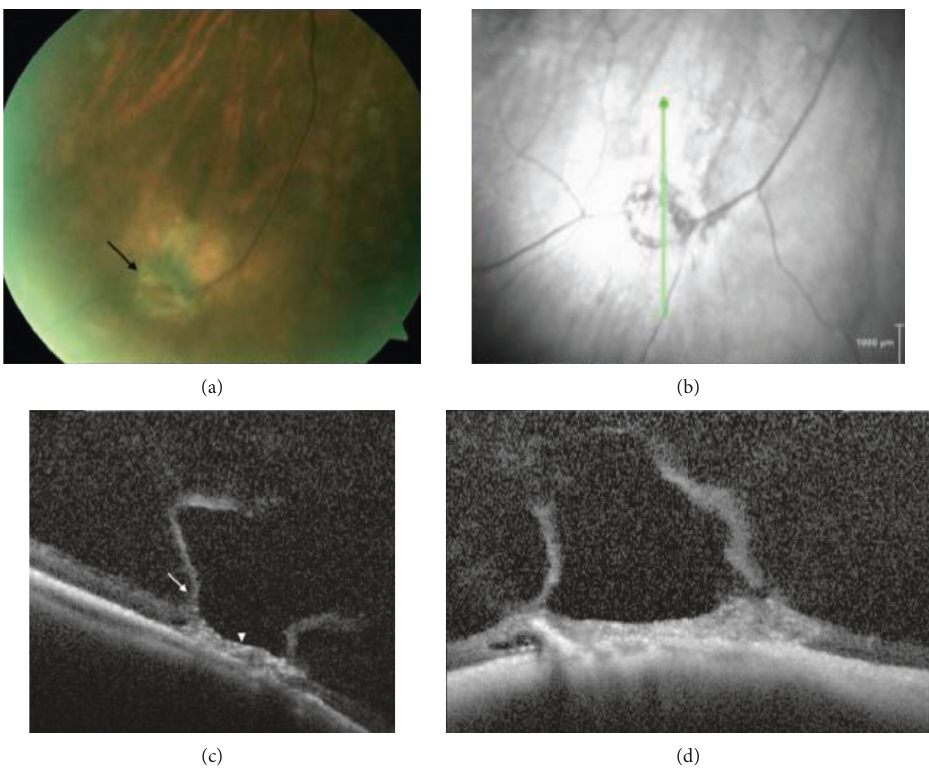
Figure 1: Peripheral SD-OCT of lattice degeneration with vitreoretinal traction. (a) Fundus photograph of the right eye with focal lattice degeneration and bridging vessel diagnosed with probable full-thickness break with ophthalmoscopy. (b) Scanning laser ophthalmoscopic image demonstrates circumferential hypoautofluorescence and scan position (green arrow) for SD-OCT in (c) and (d), which show the boundaries of cortical vitreous lacuna (arrow) overlying an area of lattice degeneration (arrowhead) with retinal atrophy, intraretinal pigment migration, and retinal pigment epithelium (RPE) irregularity; no full-thickness component was